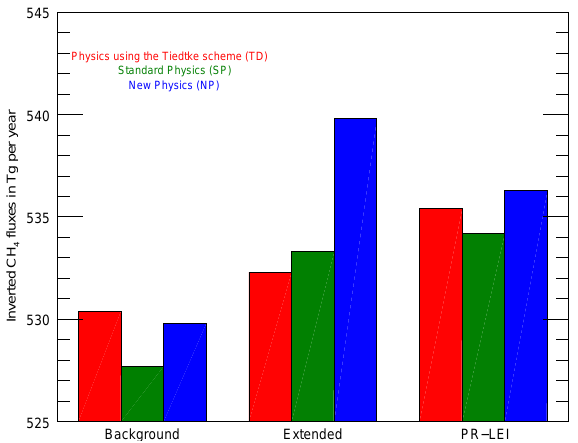
Figure 4. Methane flux estimates (inTgCH 4 year − 1 ) for 2010 at the global scale for each inversion (surface inversions using the background and the extended networks, and inversions using proxy products provided by the University of Leicester relative to GOSAT). Inversions using LMDz-TD, LMDz-SP and LMDz-NP as CTM are plotted in red, green and blue,